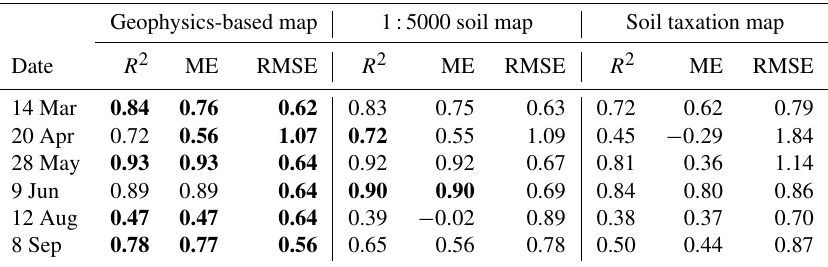
Table 4. R 2 , ME, and RMSE of the pixel-by-pixel comparison of the three soil maps performed between simulated LAI and observed LAI NDVI of each soil–crop unit. The highest R 2 and ME and the lowest RMSE at each date are marked in bold. Geophysics-based map 1:5000 soil map Soil taxation map Date R 2 ME RMSE R 2 ME RMSE R 2 ME RMSE 14 Mar 0.84